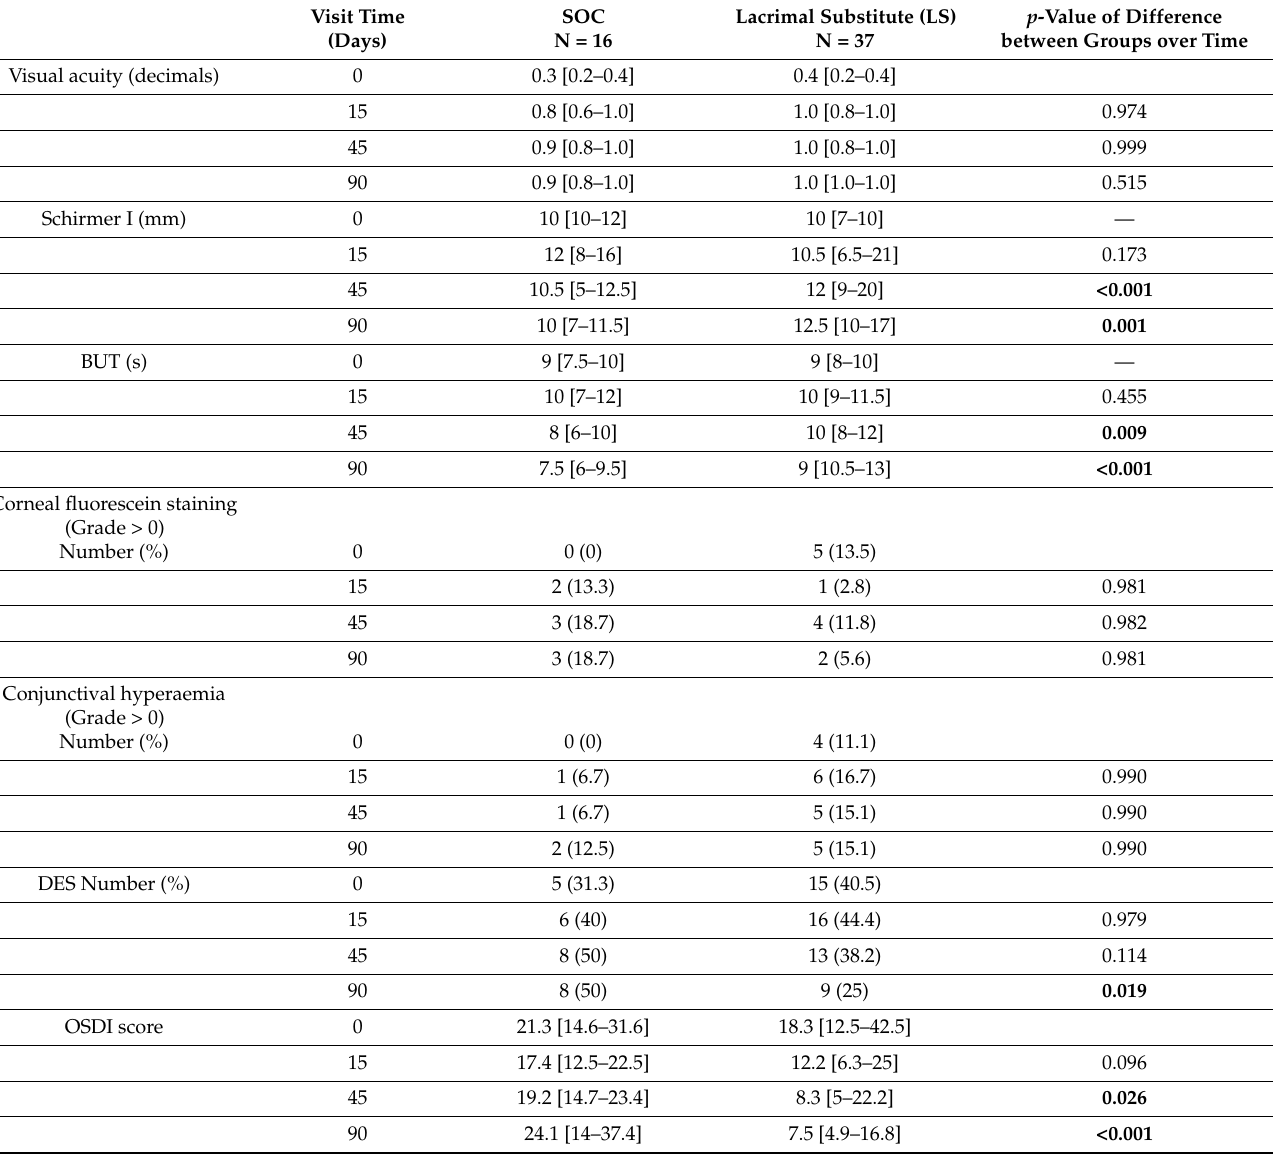
Table 2. Clinical signs over time (SOC = standard of care; BUT = break up time; DES = dry eye syndrome = BUT < 10 sec plus Schirmer I < 10 mm; OSDI = ocular surface disease index).